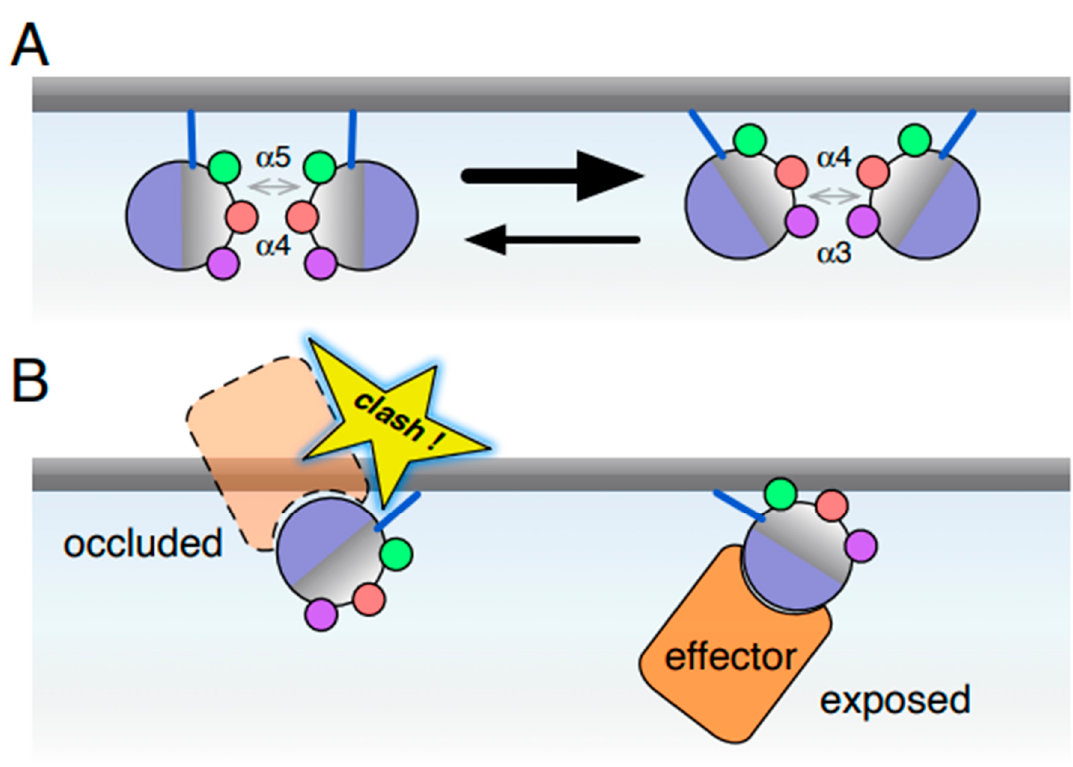
Figure 3. Ras dimerization and reorientation affect access to binding partners. ( A ) Several dimer interfaces for Ras have been proposed. The most prominent ones center around either helices α 4 and α 5 or helices α 3 and α 4. Dimer affinities are expected to be weak, even if Ras concentration is effectively elevated in the 2D membrane. ( B ) Reorientation of Ras on the membrane may occlude the effector lobe, thus restricting access to binding partners such as effectors. Reorientation and dimerization employ overlapping secondary structural elements, such as helix α 4. Therefore, it can be expected that they mutually affect each one another.